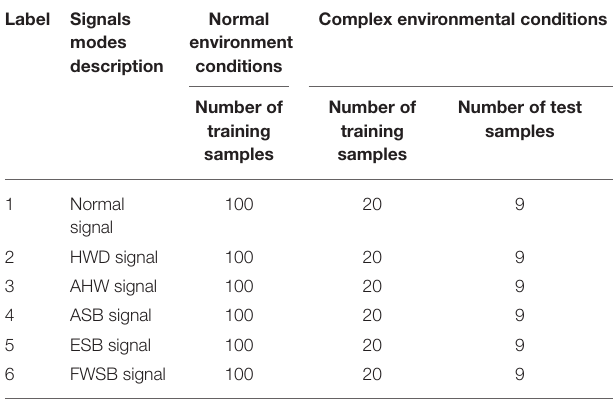
TABLE 2 | Labels and samples under normal and complex environmental